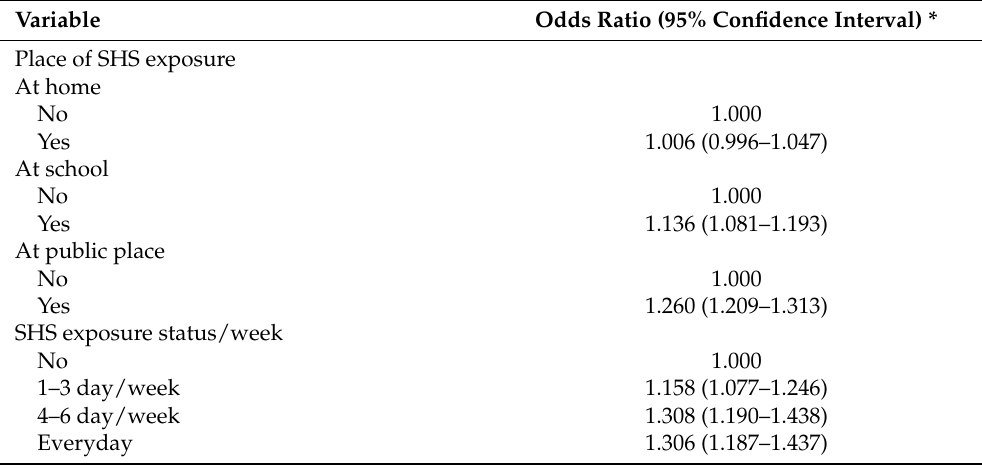
Table 3. Association of the secondhand smoking exposure place and frequency with allergic diseases in